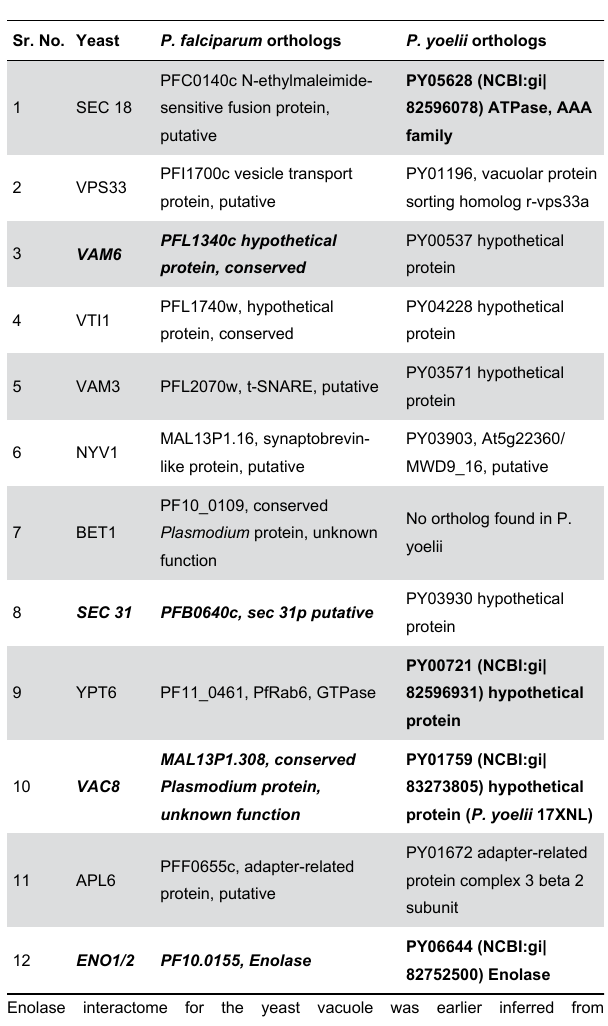
Table 2. Interactome of vacuolar enolase in yeast, P. falciparum and P. yoelii .